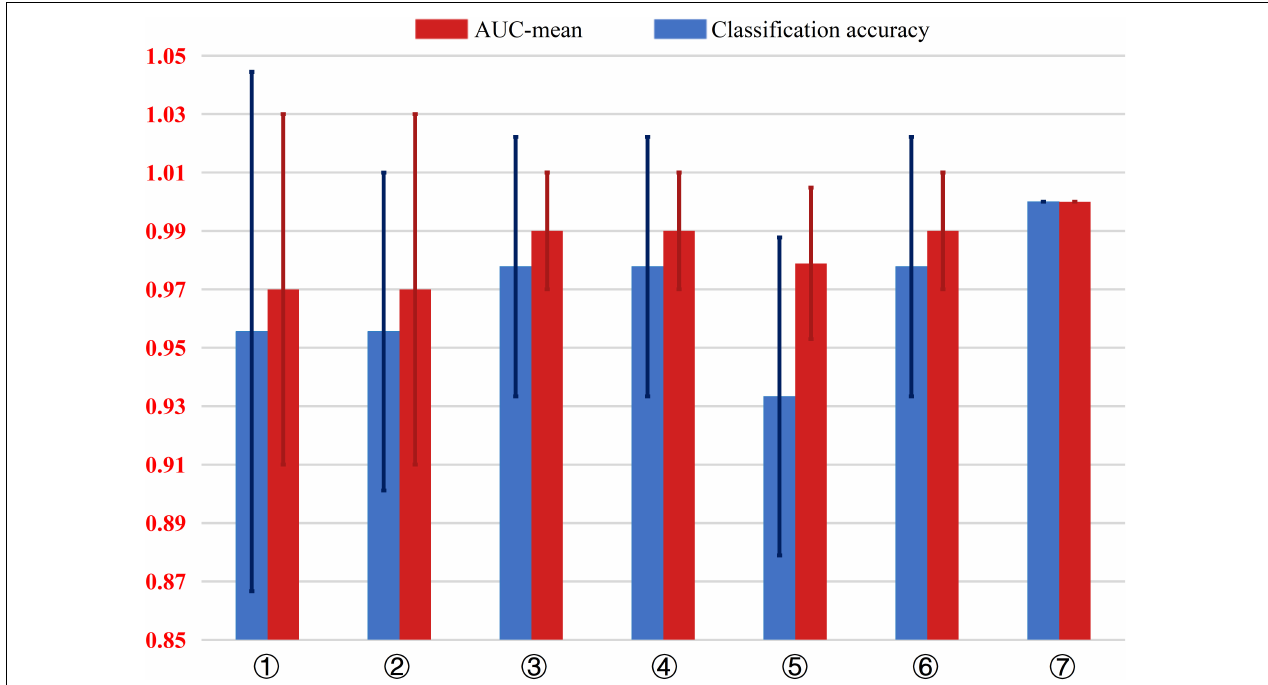
FIGURE 4 | Comparison of the classification accuracy and AUC value of 7 different AD classification models. The input dataset of model (cid:192) are 54 structural data. The input dataset of model (cid:193) are 54 structural data and 4 metabolite levels data including GABA +, Glu/Cr, NAA/Cr in the parietal region and NAA/Cr in the frontal region. The input dataset of model (cid:194) are 54 structural data and GABA + in the parietal region. The input dataset of model (cid:195) are 54 structural data and Glu/Cr in the parietal region. The input dataset of model (cid:196) are 54 structural data and NAA/Cr in the frontal region. The input dataset of model (cid:197) are 54 structural data and NAA/Cr in the parietal region. The input dataset of model (cid:198) are 54 structural data and GABA +, Glu/Cr and NAA/Cr in the parietal region.